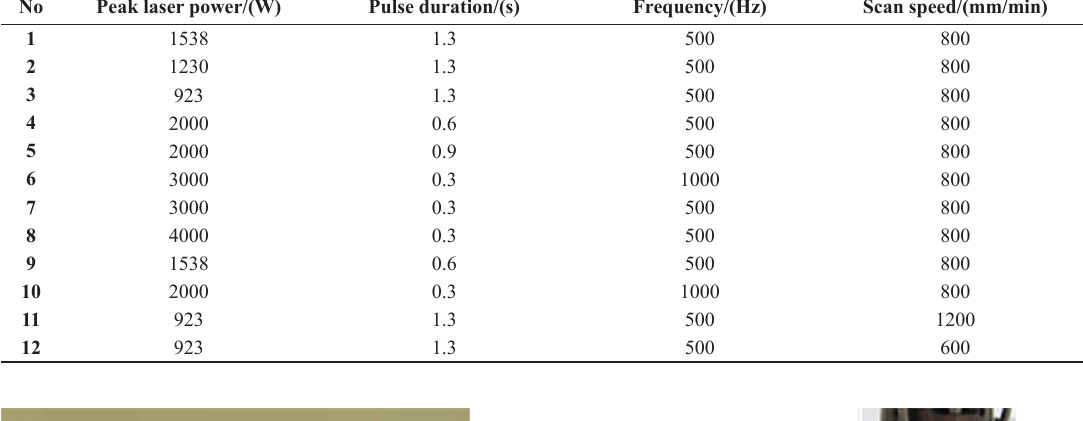
Table 1. Parameters used for deposition of Ti6Al4V thin wall samples.